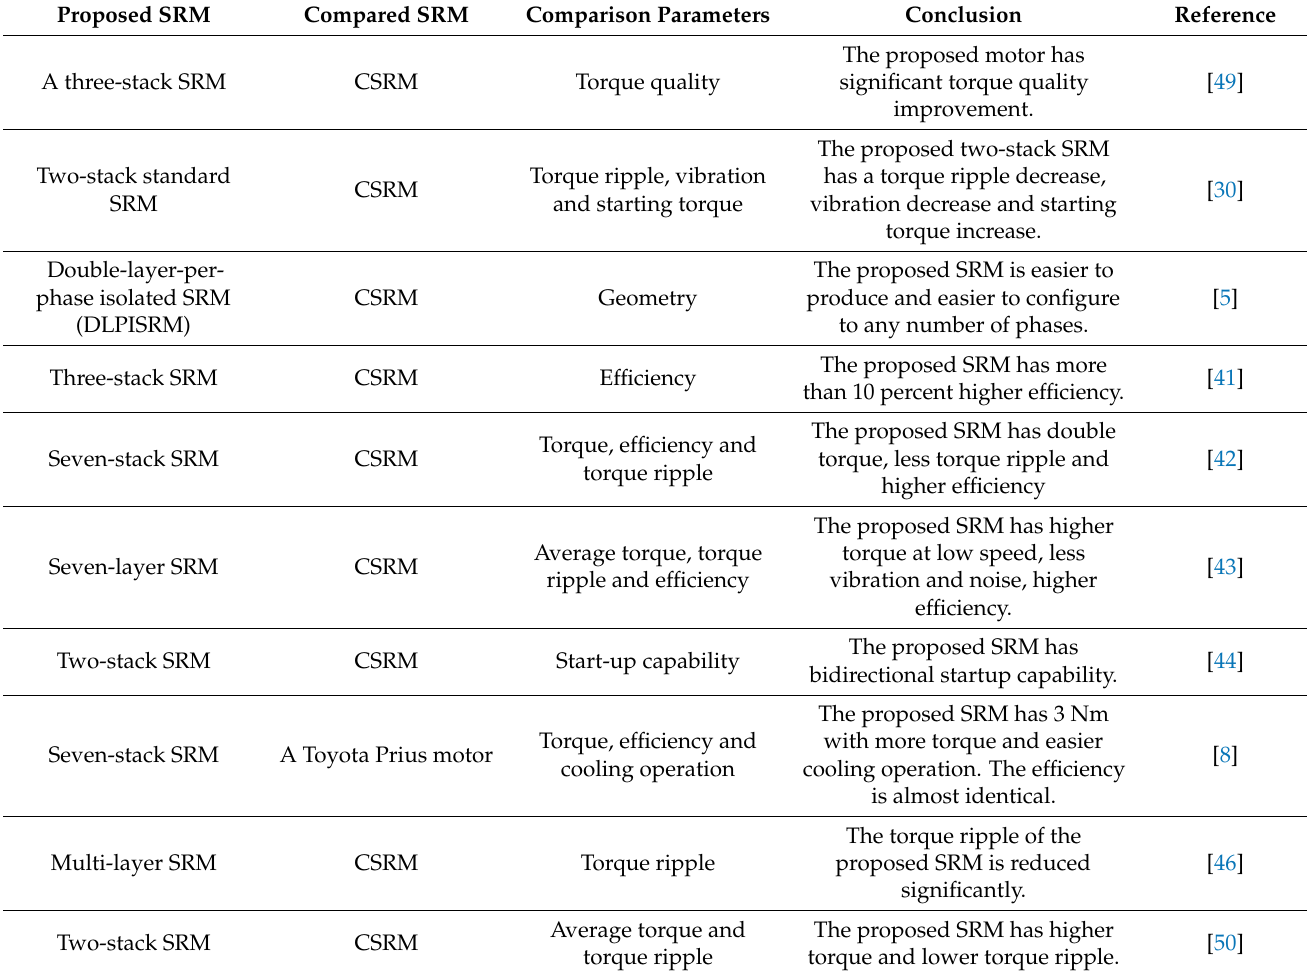
Table 1. Conventional SRM comparison according to stack